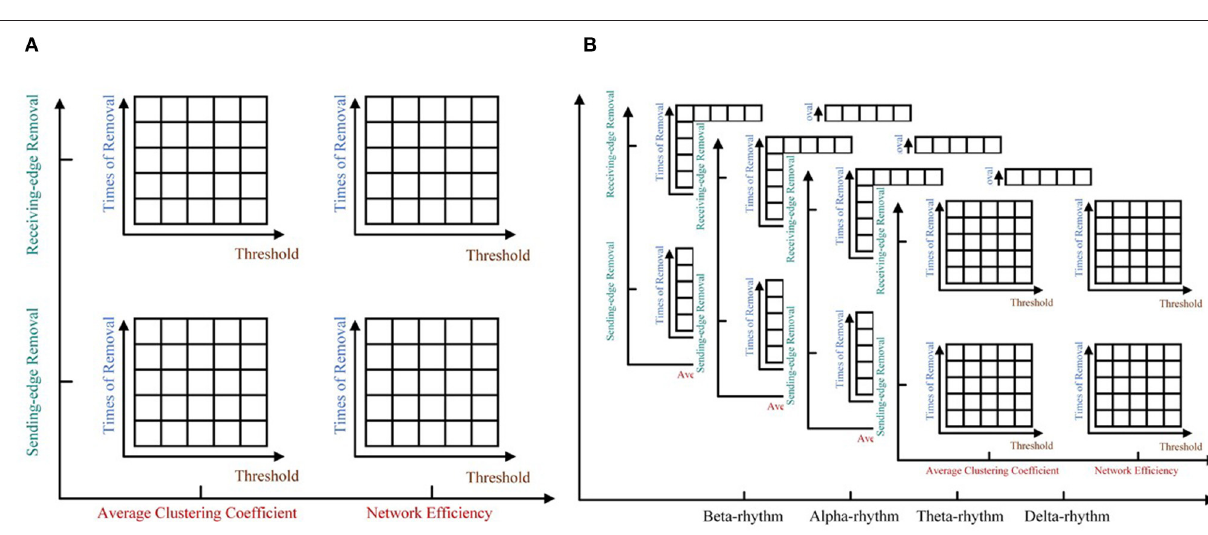
Frontiers in Neuroscience |